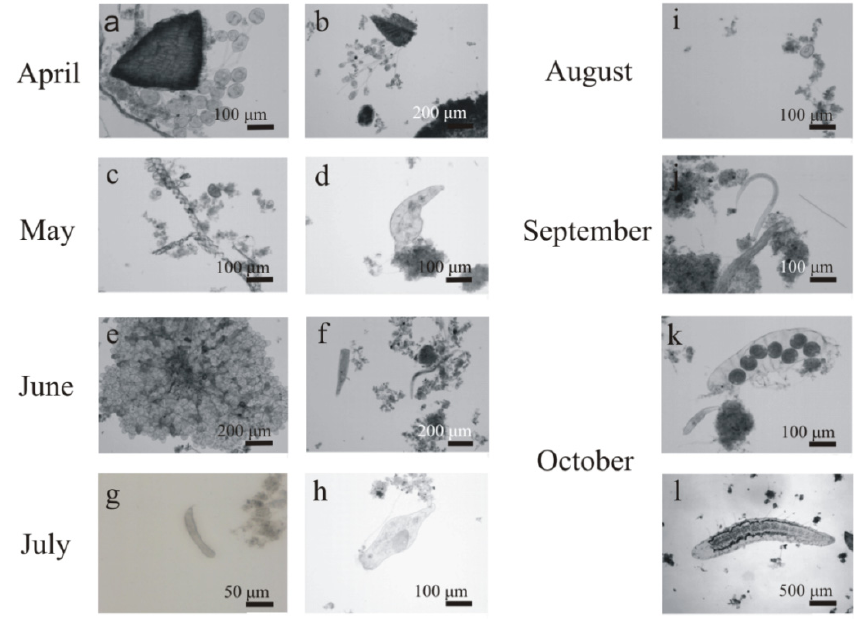
Figure 10. Examples of characteristic microorganisms observed in the activated sludge during the period of 184 days of operation from April to October 2021 (figures ( a – l ) are referred to in the text).